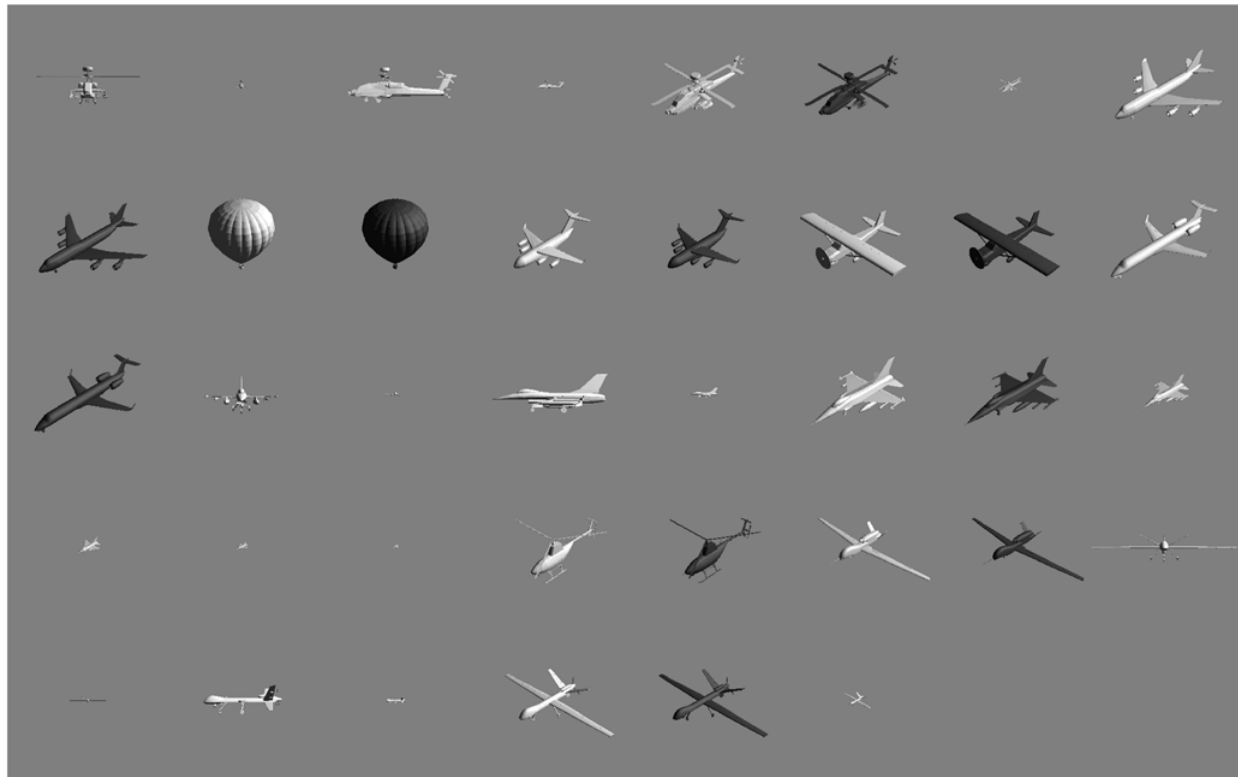
Figure 5. Aircraft images used in the visibility experiment. Aircraft vary in type, size (distance), orientation, and contrast (darker or lighter than